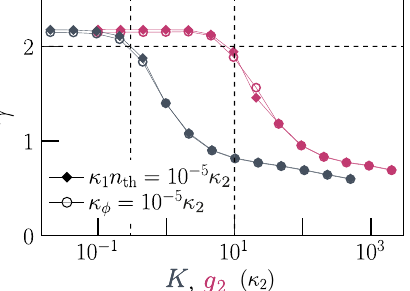
FIG. 7. Exponential suppression factor of bit-flip errors γ , such that (cid:10) bit flip ∝ exp ( − γ | α | 2 ) , for an idle cat qubit confined with a combined dissipative and Hamiltonian scheme, for either a TPE Hamiltonian (purple) or a Kerr Hamiltonian (gray), in units of κ 2 . The γ value is computed from an exponential fit over the range 2 ≤ | α | 2 ≤ 12. The cat qubit is subject to single- photon loss of amplitude κ 1 = 10 − 3 κ 2 , in addition with thermal excitations κ 1 n th = 10 − 5 κ 2 (diamonds) or pure dephasing κ φ = 10 − 5 κ 2 (circles). Dashed lines show the approximate boundary of the γ ≥ 2 exponential suppression regime, at g 2 /κ 2 = 10 and K /κ 2 = 0.3,